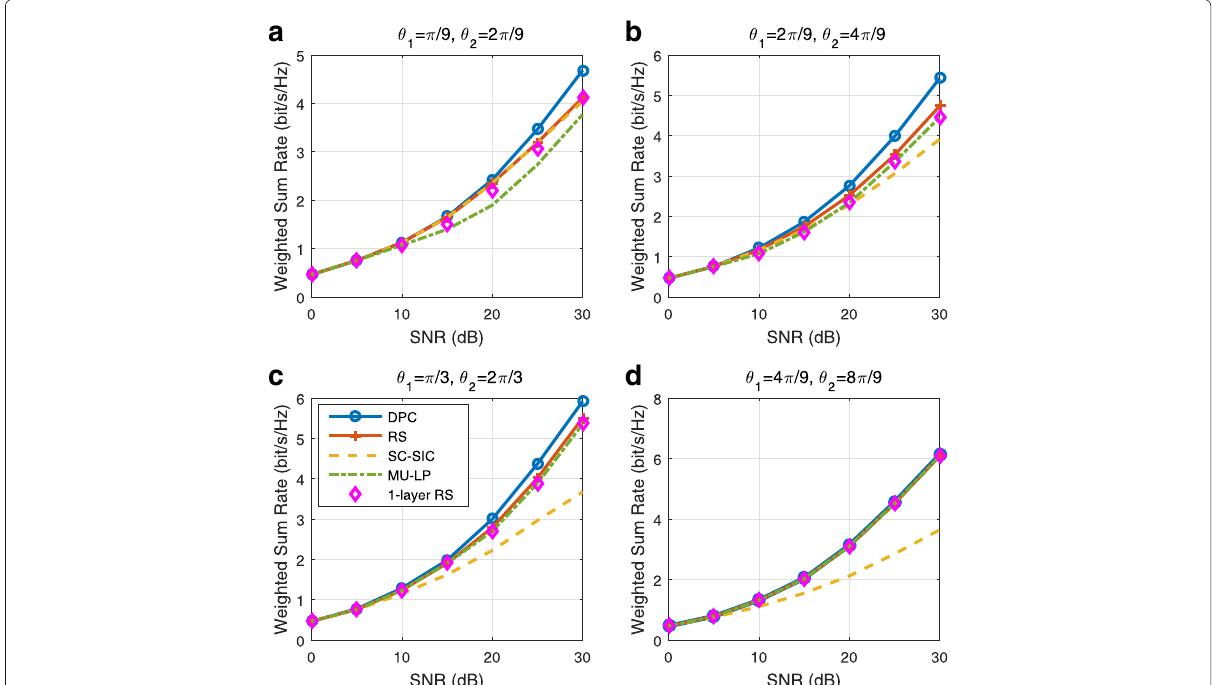
Fig.36 WeightedsumrateversusSNRcomparisonofdifferentstrategiesforunderloadedthree-userdeploymentwithperfectCSIT, γ 1 = 0.3, γ 2 = 0.1,